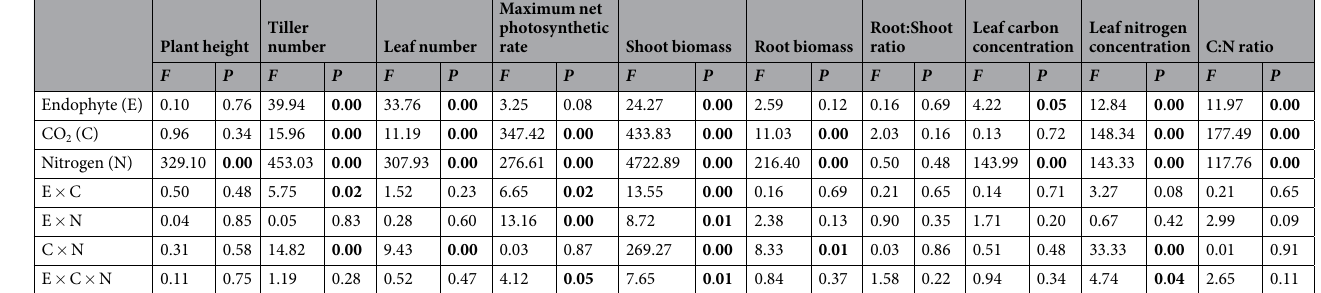
C 3 plant) and purpletop grass ( Tridens flavus , a C 4 plant), the growth of endophyte-infected (E + ) and uninfected (E − ) plants responded similarly to CO 2 enrichment. Also in perennial ryegrass, Hunt, et al . 8 reported that E + biomass tended to be greater than E − plants only at elevated CO 2 , and they further found that E − plants had 40% lower concentrations of soluble protein under elevated CO 2 than under ambient CO 2 , but this CO 2 effect on soluble protein was absent in E + plants. In tall fescue ( Lolium arundinaceum ), Newman, et al . 9 did not find interaction between CO 2 concentration and endophyte infection in the growth, but they found soluble crude protein concentration increased under elevated CO 2 for E − plants but not for E + plants. Ryan, et al . 30 reported